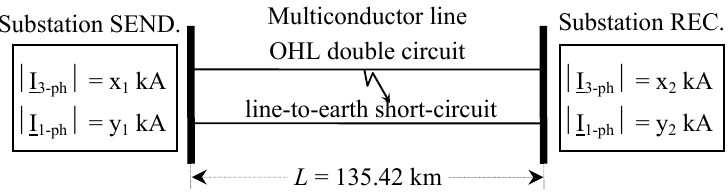
Figure 15. Multiconductor line in short-circuit condition supplied by end